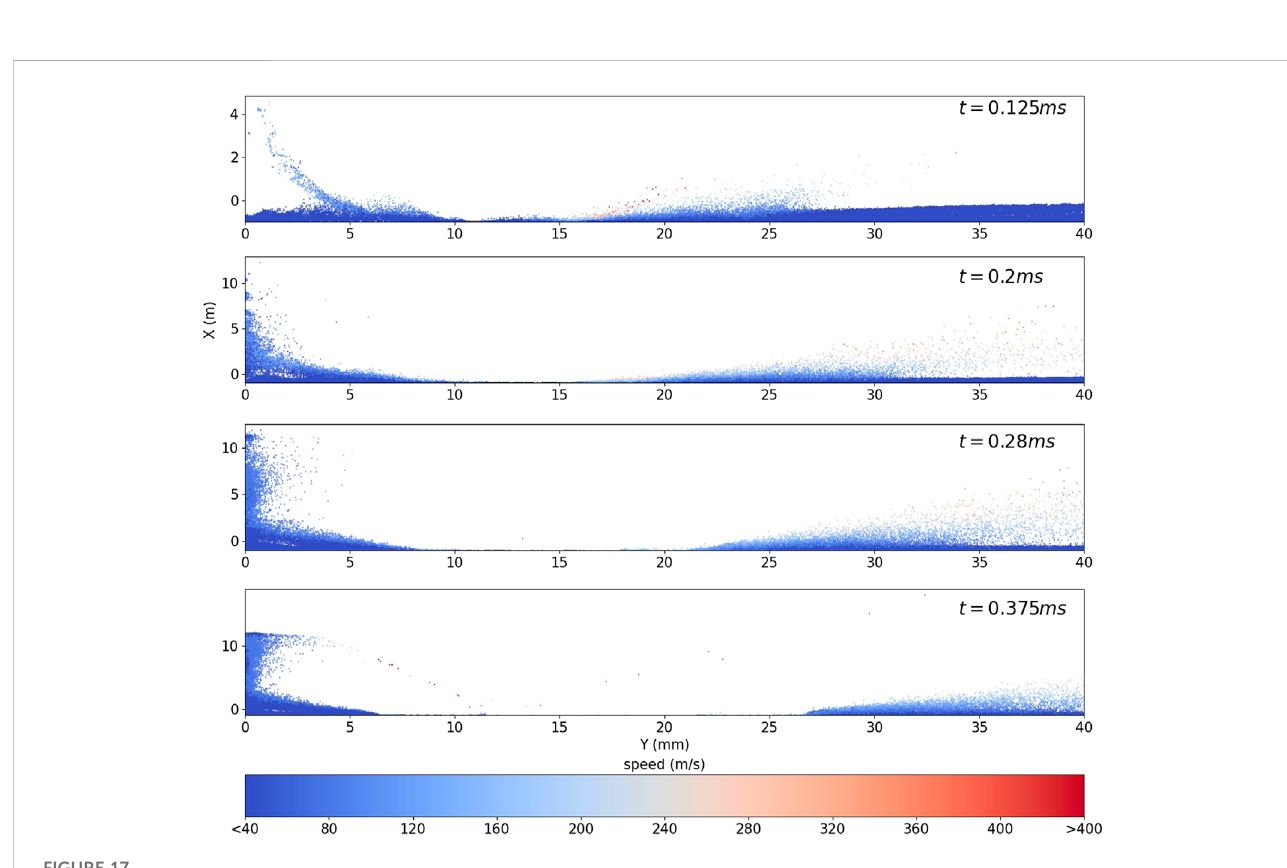
Regolith layer evolution with the stochastic model: